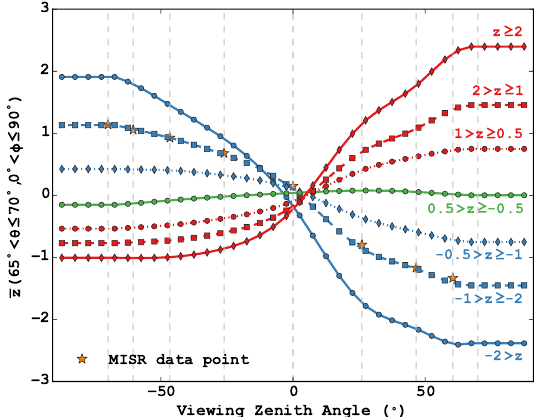
Figure 6. Adjustment factors interpolated from MISR angles (grey dashed lines) onto a 5 ◦ θ grid for use with CERES measurements. These adjustment factors are for the case when 65 ◦ ≤ θ v < 70 ◦ and φ< 90 ◦ . Each of these lines represents a set from β(θ c ,φ f/b ,z) θ The orange stars show the locations of the MISR values from which the blue squares’ values were interpolated.